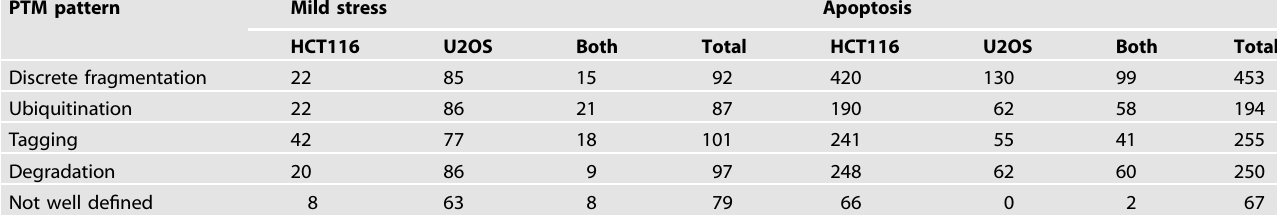
Table 1. Number of detected proteins with speci fi c PTMs pattern induced by mild stress and apoptosis.